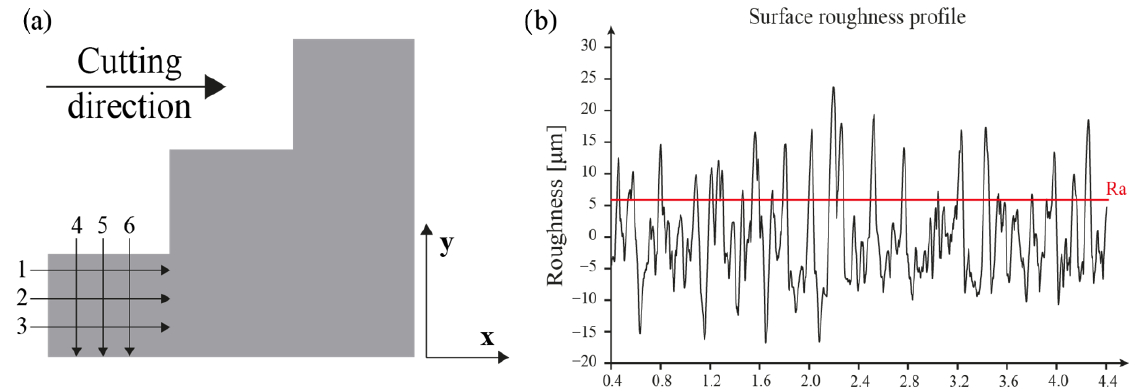
Figure 2. ( a ) Measurement directions for the evaluation of bulk workpiece surface roughness (Ra); ( b ) surface roughness profile and Ra value.